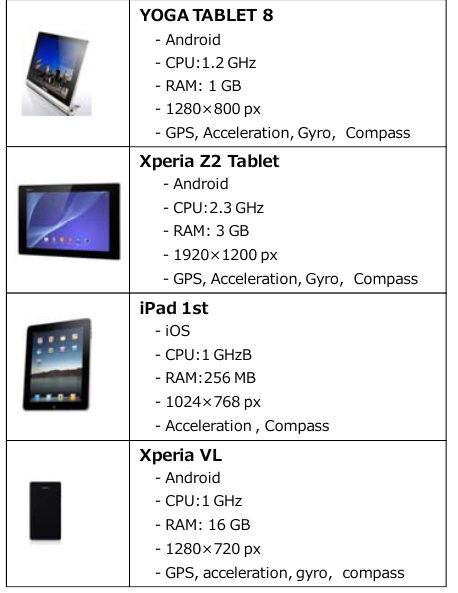
Figure 9. Mobile devices (tablet PCs and smart